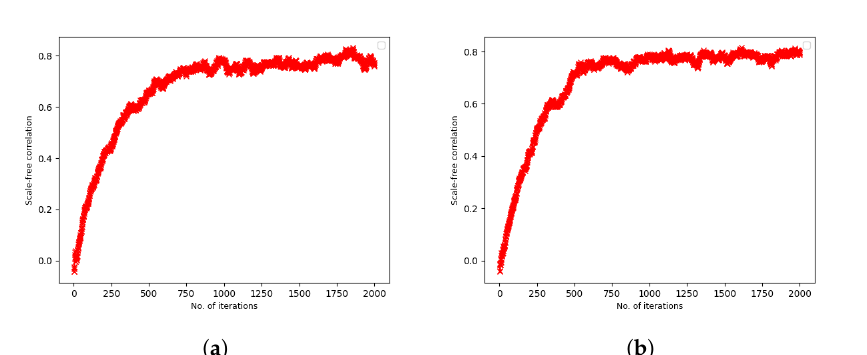
Figure 2. System rationality against the number of iterations of network rewiring. The system ratio- nality increases and stabilizes over 2000 iterations of rewiring when preferential rewiring based on node-rationality occurs. This happens whether the node rationality is ( a ) positively or ( b ) negatively correlated with the degree. Therefore, preferential rewiring based on the node rationality parameter results in increased system rationality.